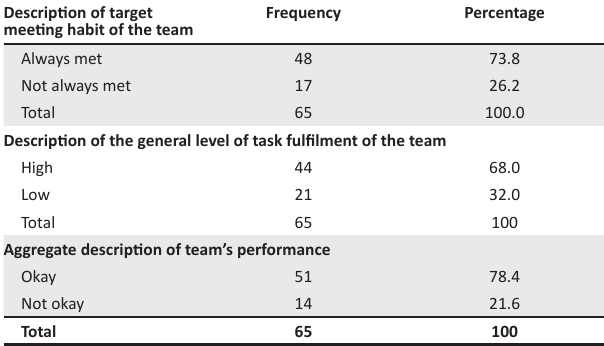
TABLE 2: Descriptive analysis of work delivery prospect of the team